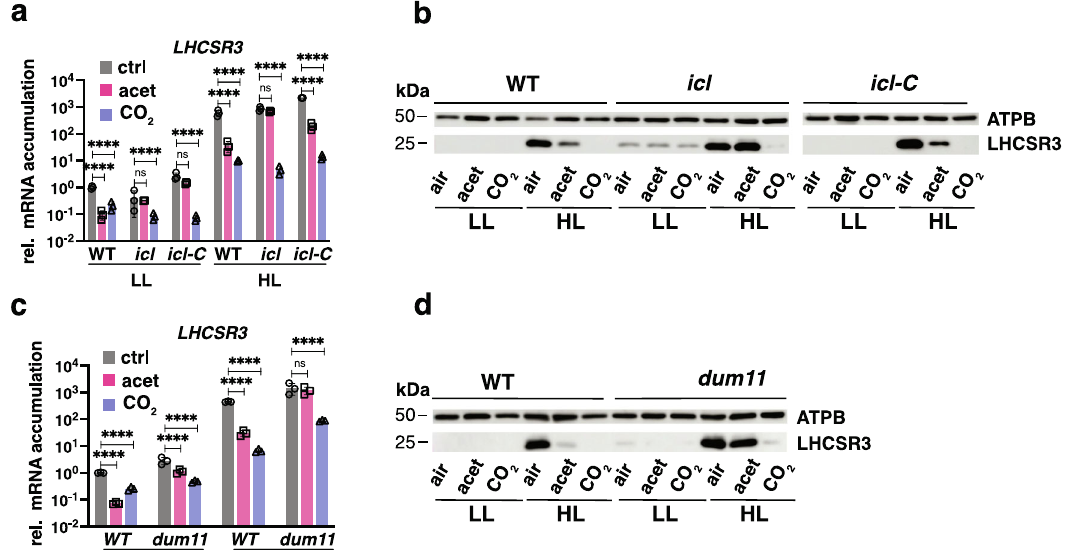
Fig. 1 | Acetate needs to be metabolized to inhibit LHCSR3 accumulation. WT, icl , icl-C and dum11 strainswereacclimatedfor16hinLL(15 µ molphotonsm − 2 s − 1 )in HSM; sparged with air (labelled as “ air ” ); sparged with air and supplemented with 10mM sodium acetate (labelled as “ acet ” ); sparged with air enriched with 5% CO 2 (labelled as “ CO 2 ” ). After sampling for the LL conditions, light intensity was increased to 600 µ mol photons m − 2 s − 1 (HL); samples were taken 1h (RNA) or 4h (protein)afterexposuretoHL. a , c .Accumulationof LHCSR3